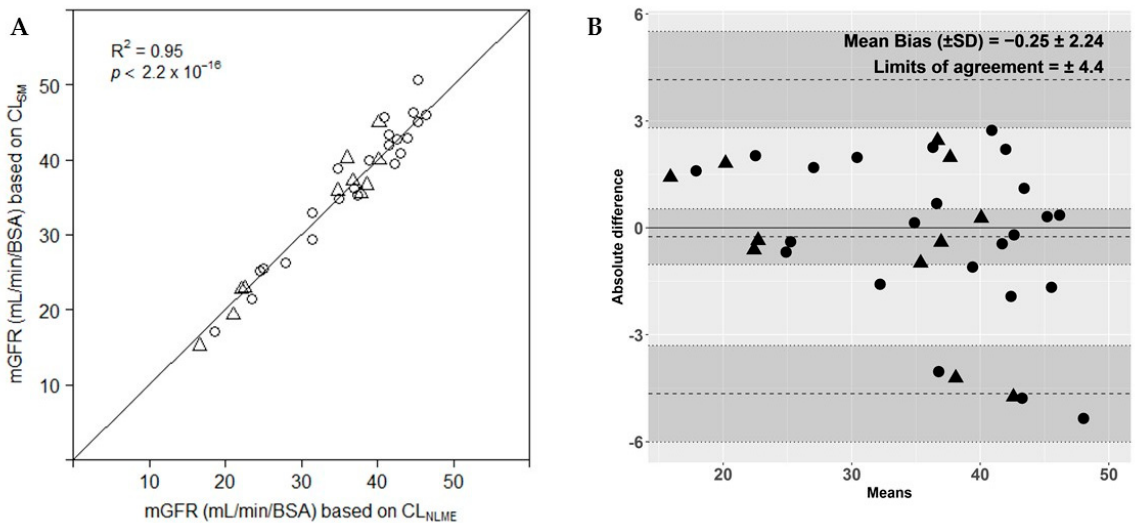
Figure 5. ( A ): Comparison of measured glomerular filtration rate (mGFR) based on clearance determined by a nonlinear mixed effects model (CL NLME ) vs. the mGFR based on clearance determined by the simplified method (CL SM ). All GFR values were adjusted for body surface area (BSA), assuming a BSA of 1.43 m 2 in goats and 1.19 m 2 in pigs. Solid line, line of unity; triangles, goat; circles, pig. ( B ): Bland–Altman plot of agreement between measured glomerular filtration rate (mGFR) based on plasma clearance determined by a nonlinear mixed effects model (CL NLME ) and mGFR based on clearance determined by the simplified method (CL SM ) for goats (triangles) and pigs (circles). Dotted lines represent bias, upper and lower limits of agreement. Grey shaded areas represent the 95% confidence intervals of the bias, upper and lower limits of agreement.